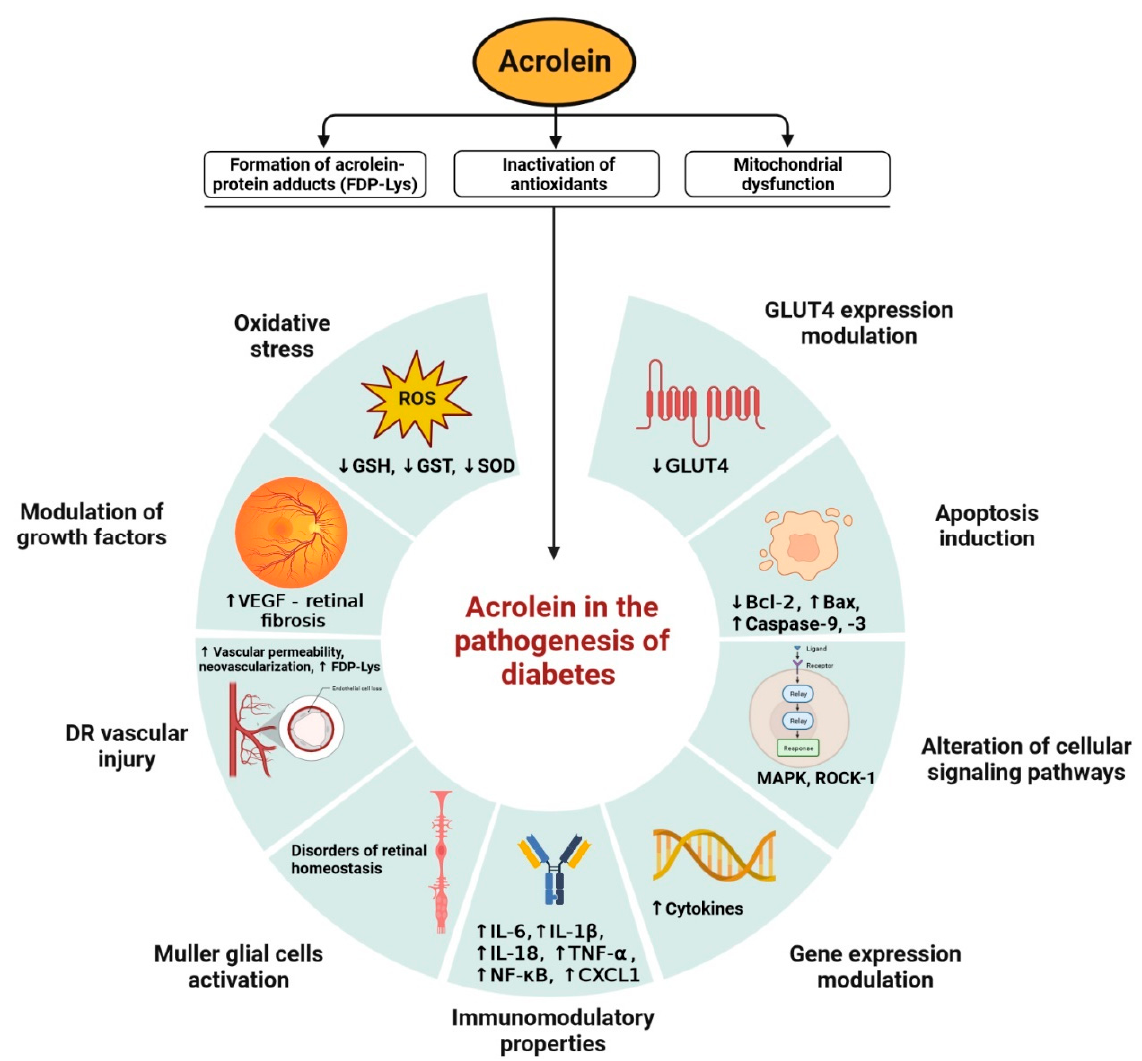
Figure 1. Molecular basis of acrolein participation in the pathogenesis of diabetes. Acrolein, as a highly reactive aldehyde, interacts with several proteins, leading to their inactivation. Antioxidant depletion and damage to mitochondrial function lead to further biological consequences crucial for the development and course of diabetes.